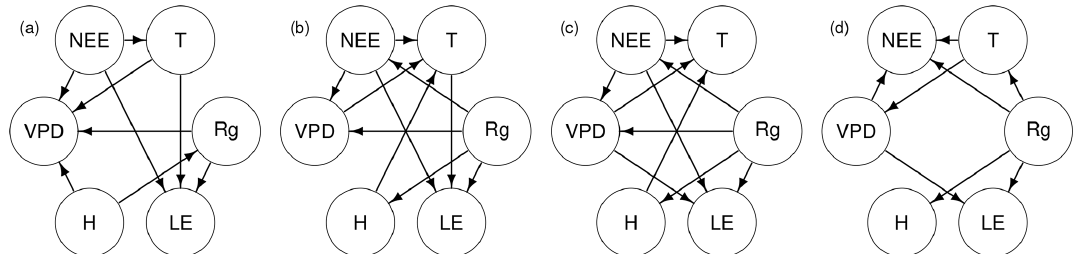
Figure 3. The PC-stable method produced the best scoring model (a) among our CSD algorithms, which was then further modified (b) by the greedy search. Greedy search produces a slightly different result (c) when initialized from an empty graph. The underlying causal structures were given a uniform prior ( k = 1 / 3). Also shown is the expert model (d) , produced by domain experts. The SHD values from the expert model to (a) , (b) and (c) are 10, 7 and